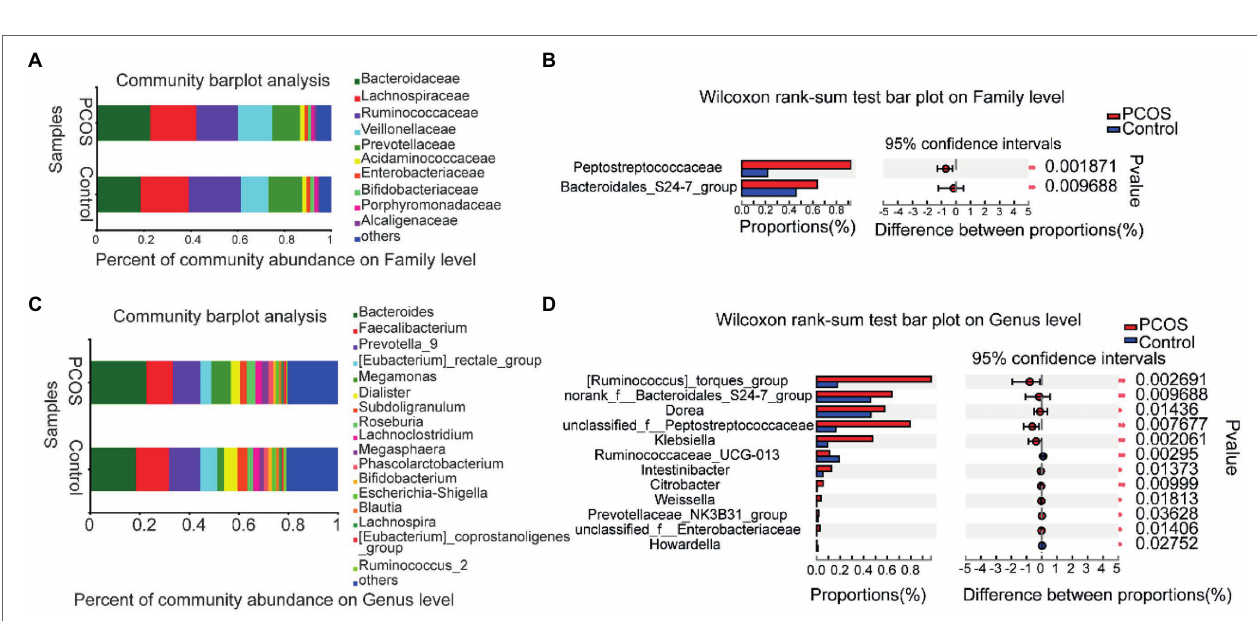
FIGURE 3 | (A–D) Comparison of gut microbial α diversity index between PCOS and healthy controls. There was no significant difference in α diversity between the two groups. (E) A Venn diagram shows the number of unique and common OTUs between the two groups. (F,G) PCoA and NMDS based on OTU distribution showed no significant difference in β diversity between the two groups. PCOS: polycystic ovary syndrome ( N = 31); Control: healthy controls ( N = 27); PCoA, Principal coordinate analysis; NMDS, Non-metric multi-dimensional scaling; OTUs, Operational Taxonomic Units.